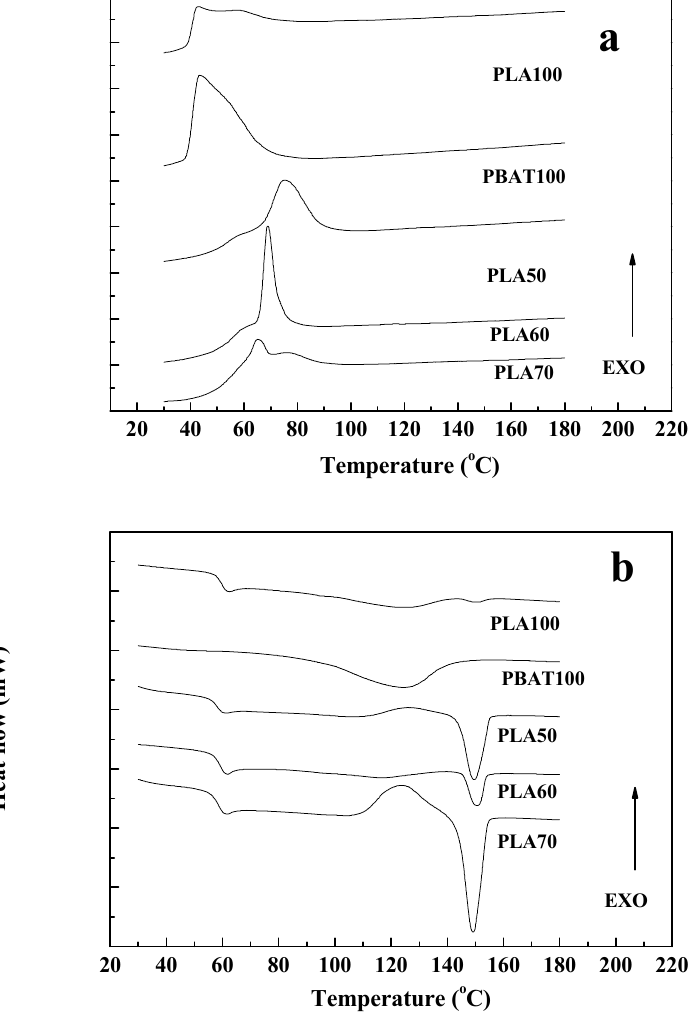
Figure 4. DSC thermograms of homopolymers and their blends: ( a ) Cooling and ( b ) second heating.